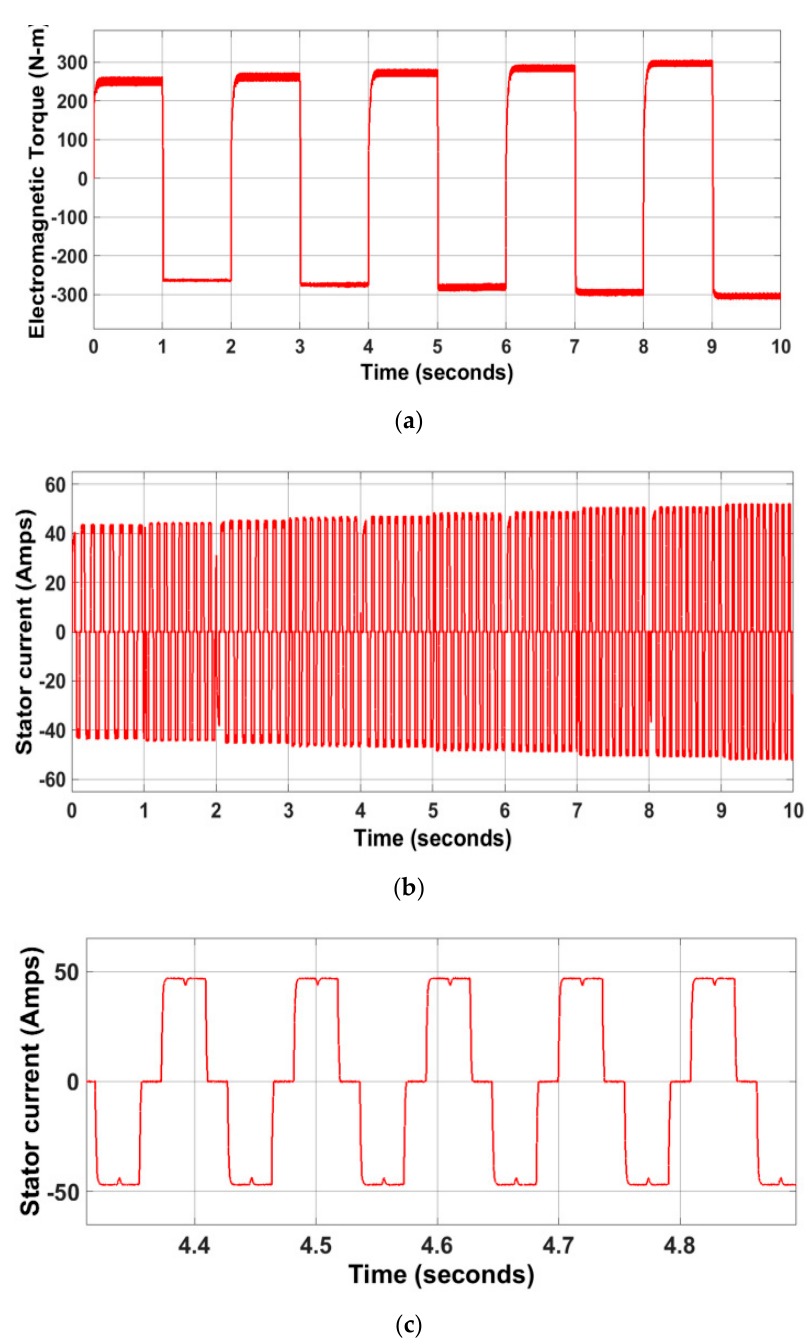
Figure 15. ( a ) Electromagnetic torque developed by a motor using the parameters of 1040 HR steel; ( b ) stator current in Phase A of a motor using the parameters of 1040 HR steel; ( c ) expanded stator current waveform in Phase A of motor corresponding to 1040 HR steel.